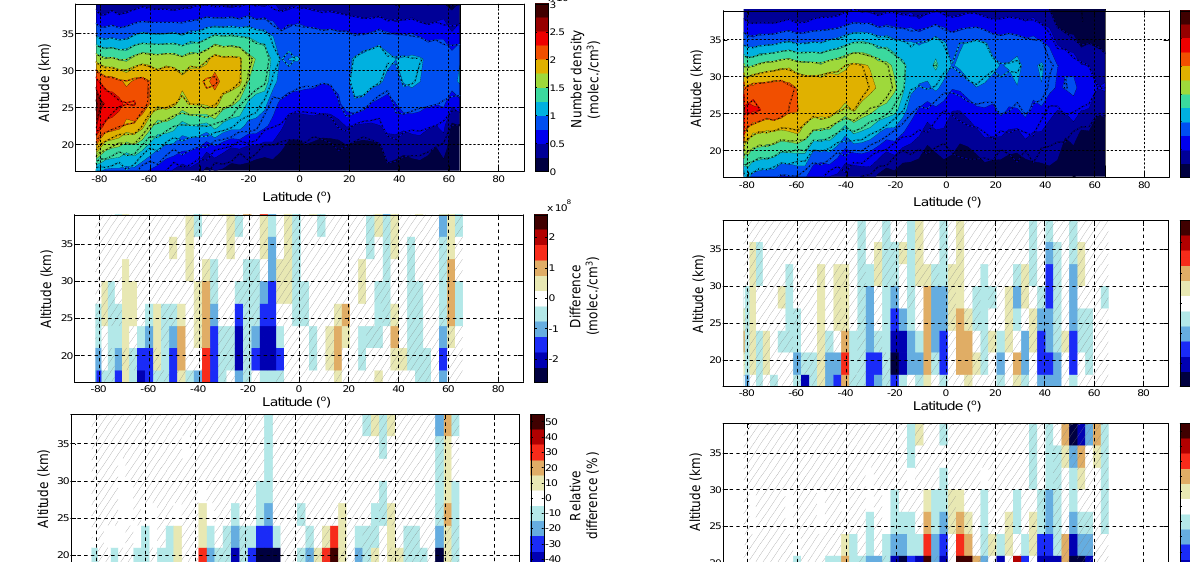
Fig. 3. Definition of the horizontal model space for the interpo- lation approach with respect to the tangent points of the scanning sequences if additional intermediate boxes are introduced. TP and dark shading indicates boxes around the tangent points, IB and white shading indicates the intermediate boxes. For illustration pur- poses, the LOS is shown for only one measurement per scanning sequence (at the same TH).